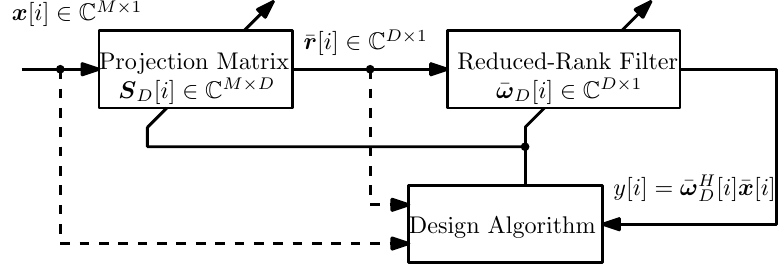
Figure 1. Schematic of the proposed reduced-rank